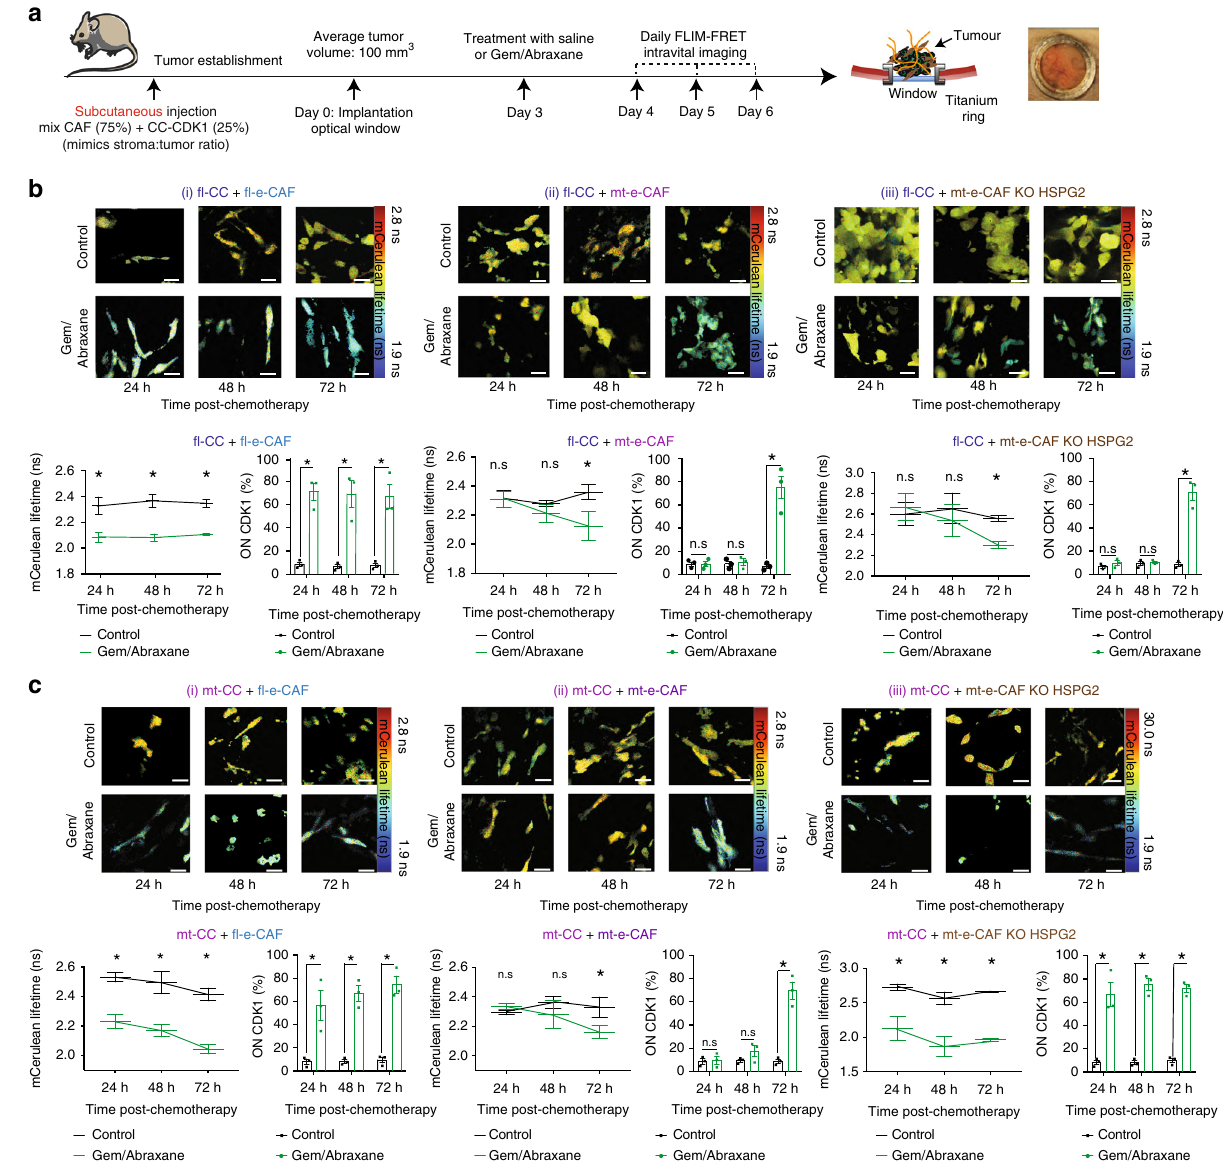
Fig. 8 mt-e-CAFs delay fl -CC and mt-CC response to chemotherapy in an HSPG2-dependent manner for mt-CCs. a Schematic of timeline of subcutaneous injection of cancer cells with CAFs, tumor development, titanium window implantation, drug treatment, and longitudinal imaging. b Representative mCerulean lifetime maps (top images) and longitudinal quanti fi cation of mCerulean lifetimes (lower left hand panels) and of CDK1 activity (lower right hand panels) in fl -CCs injected with (i) fl -e-CAFs, with (ii) mt-e-CAFs WT or with (iii) mt-e-CAFs KO HSPG2 (mixed population) 24 h, 48 h, and 72 h after treatment with control or with gemcitabine/Abraxane. Scale bar: 100 μ m, n = 3 mice per group. c Representative mCerulean lifetime maps (top images) and longitudinal quanti fi cation of mCerulean lifetimes (lower left hand panels) and CDK1 activity (lower right hand panels) in fl -CCs injected with (i) fl -e- CAFs, with (ii) mt-e-CAFs WT or with (iii) mt-e-CAFs KO HSPG2 (mixed population) at 24 h, 48 h, and 72 h after treatment with control or with gemcitabine/Abraxane. Scale bar: 100 μ m, n = 3 mice per group. The threshold was calculated based on values between untreated and treated mice at 24 h post-treatment with gemcitabine/Abraxane for each group of cells co-injected subcutaneously. See Supplementary information for details on calculation of threshold. Individual data points are presented with mean values and SEM. * p <